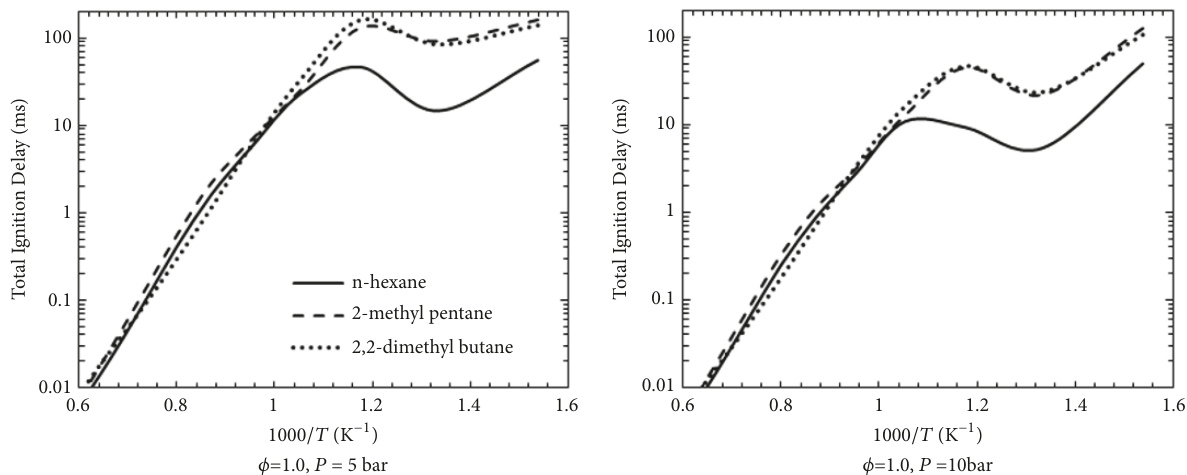
Figure 3: Simulatedignition delay times for the hexaneisomers in air at pressuresof 5 and 10 bar and an equivalence ratioof Φ =1. Simulations were carried out using the kinetic mechanisms as developed by [25] in an adiabatic constant-volume model.